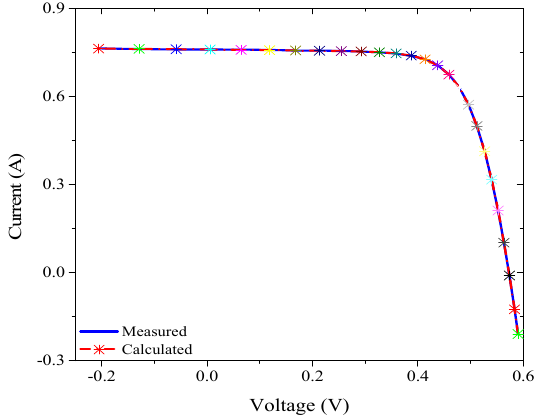
Figure 8. I–V curve of the measured and calculated currents for the double-diode cell.